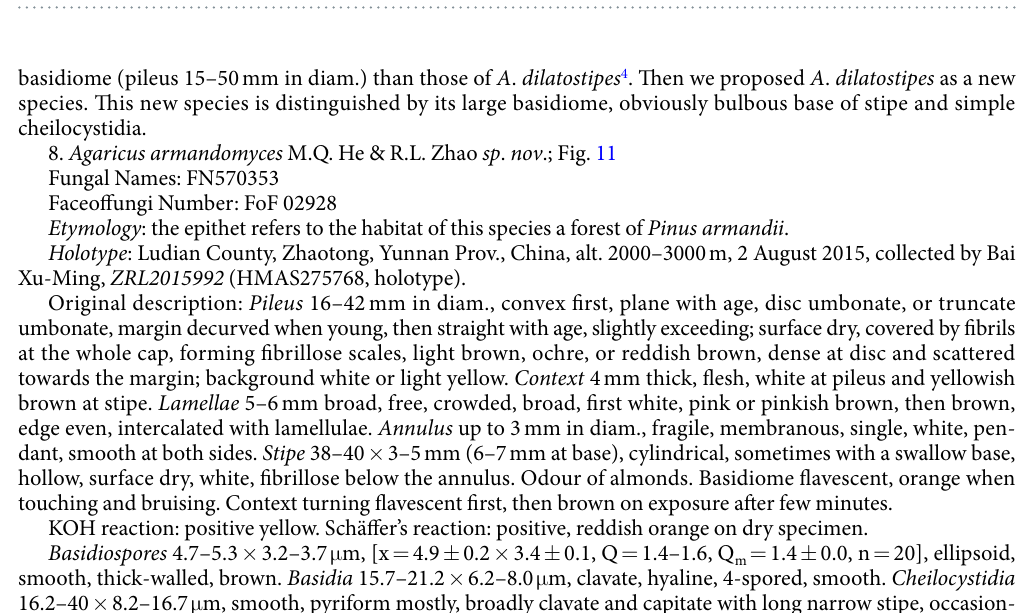
Figure 11. Morphology of Agaricus armandomyces ( ZRL2015992 , holotype), ( A ): Basidiome in field ( ZRL2015992 ), ( B ): Cheilocystidia, ( C ): Basidiospores, ( D ): Basidia, and ( E ): Pileipellis